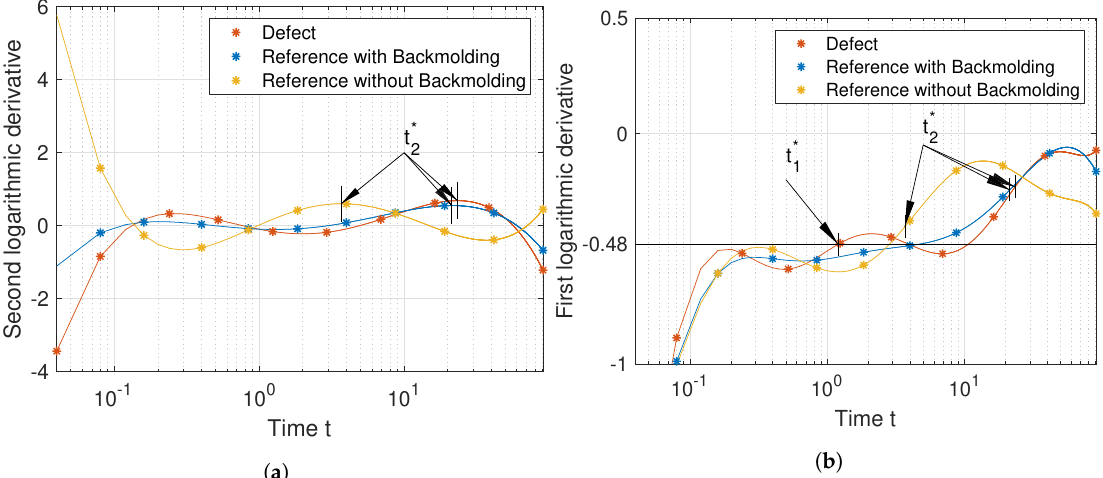
Figure 9. Polynomial derivatives of the temperature–time sequences from Figure 7a: ( a ) second logarithmic derivative of a polynomial of degree n = 6 (TSR method) and ( b ) the first logarithmic derivative of a polynomial of degree n = 9 (proposed